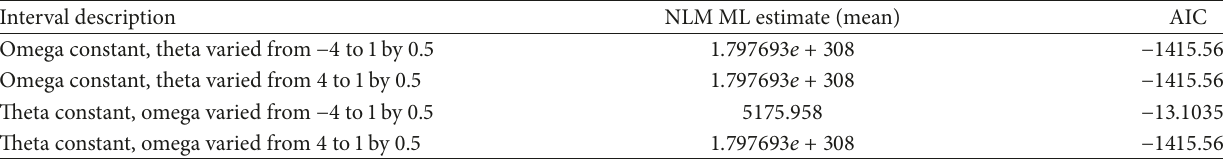
Table 12: Summary of results for lambda = 0.8, 𝑛 = 10 𝑖 , 𝑖 = 5